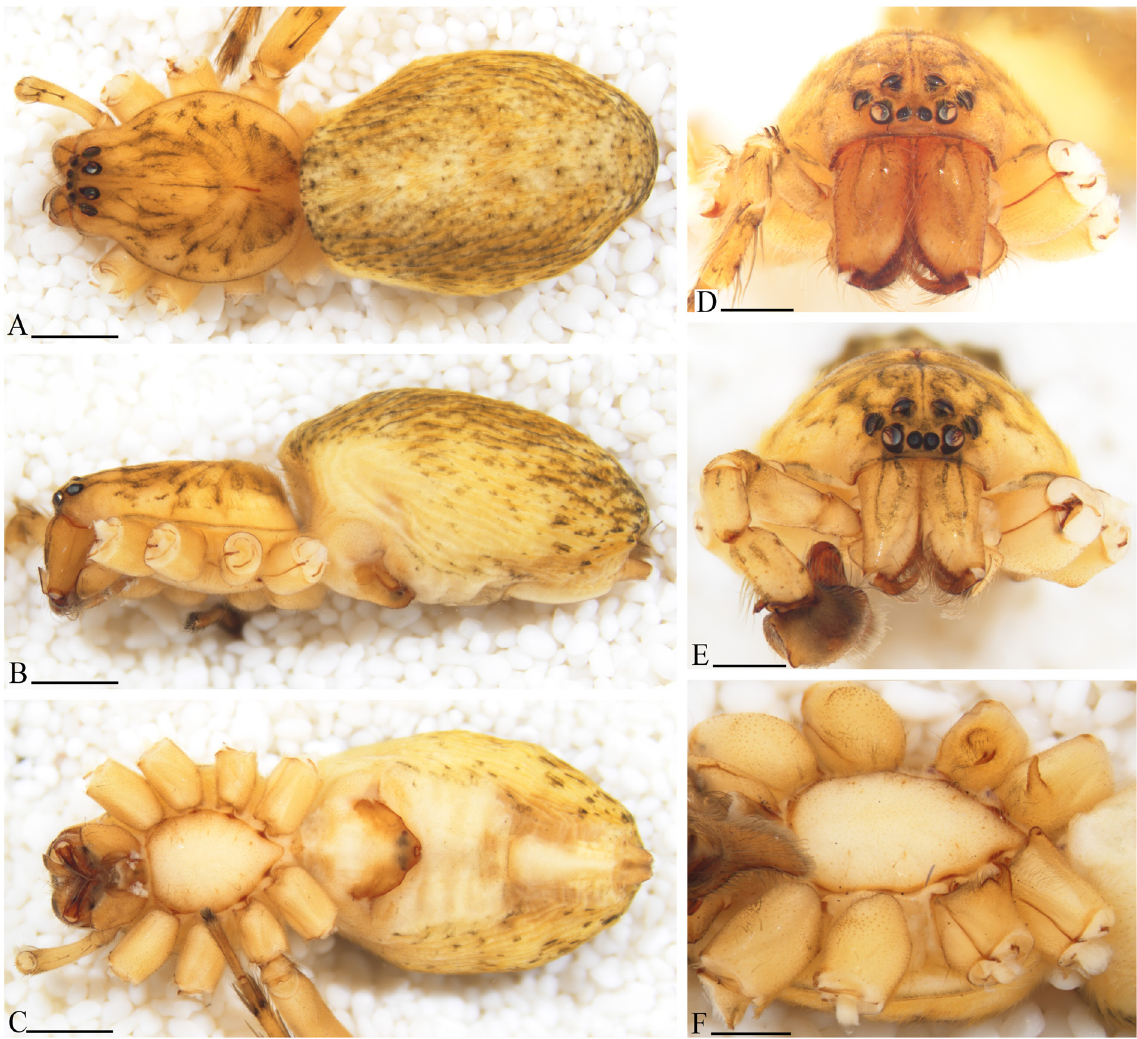
Fig. 19. Anyphaena bifurcata sp. nov. A–D . Holotype, ♀ (CNAN-T01523). E–F . Paratype, ♂ (CNAN-T01549). A . Dorsal habitus. B . Lateral habitus. C . Ventral habitus. D . Prosoma, anterior view. E . Prosoma, anterior view. F . Prosoma, oblique view. Scale bars: A–C = 1.0 mm; D–F = 0.5